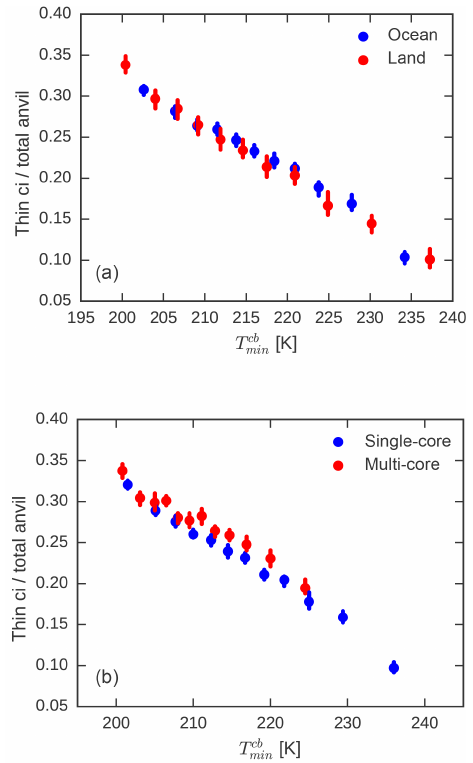
Figure 12. Median and standard error of thin cirrus over total anvil area for mature systems as a function of minimum temperature within convective core(s), for single-core systems, separately over land and ocean (a) and separately for single-core (blue) and multi- core (red) systems (b) .